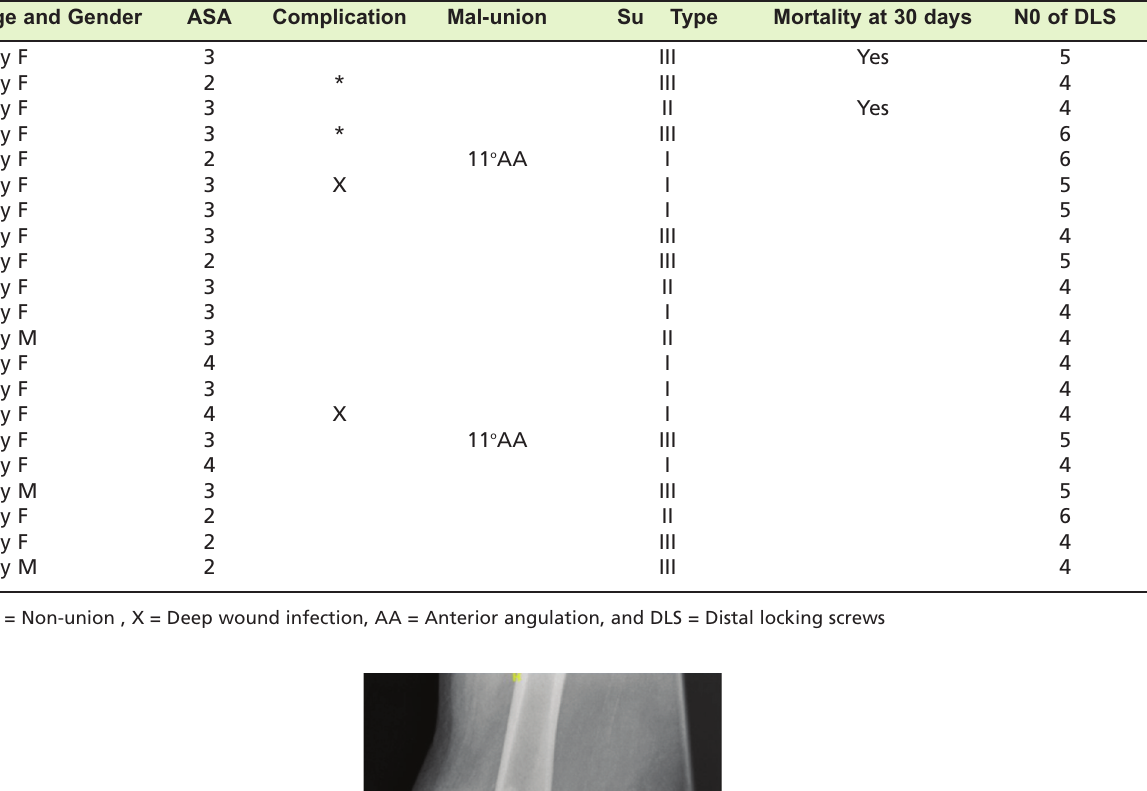
Characteristics and outcome of all cases Table I: